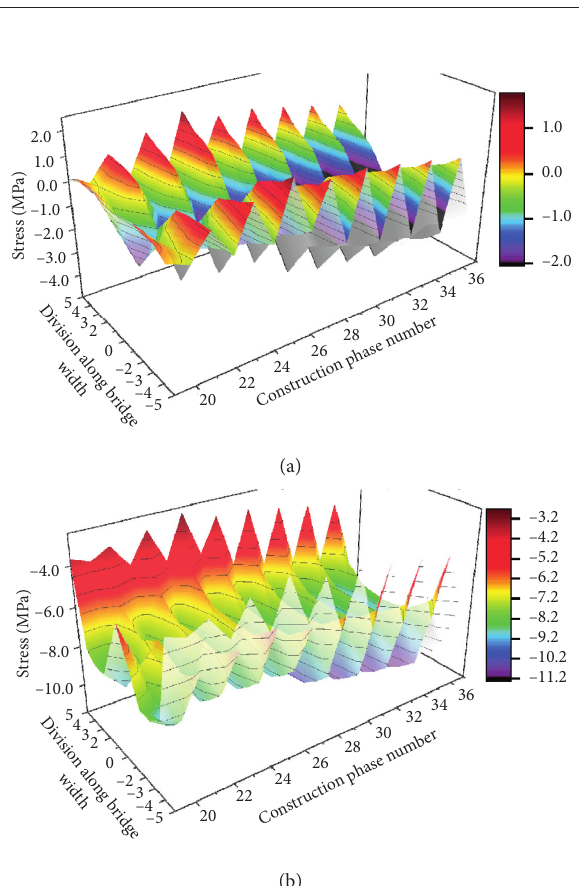
Figure 13: Effects of the rectified short prestressed tendon scheme for improvement of the safety reserve of the no.10 segment. (a) No. 10 segment upper edge without prestressing. (b) No. 10 segment upper edge with prestressing.